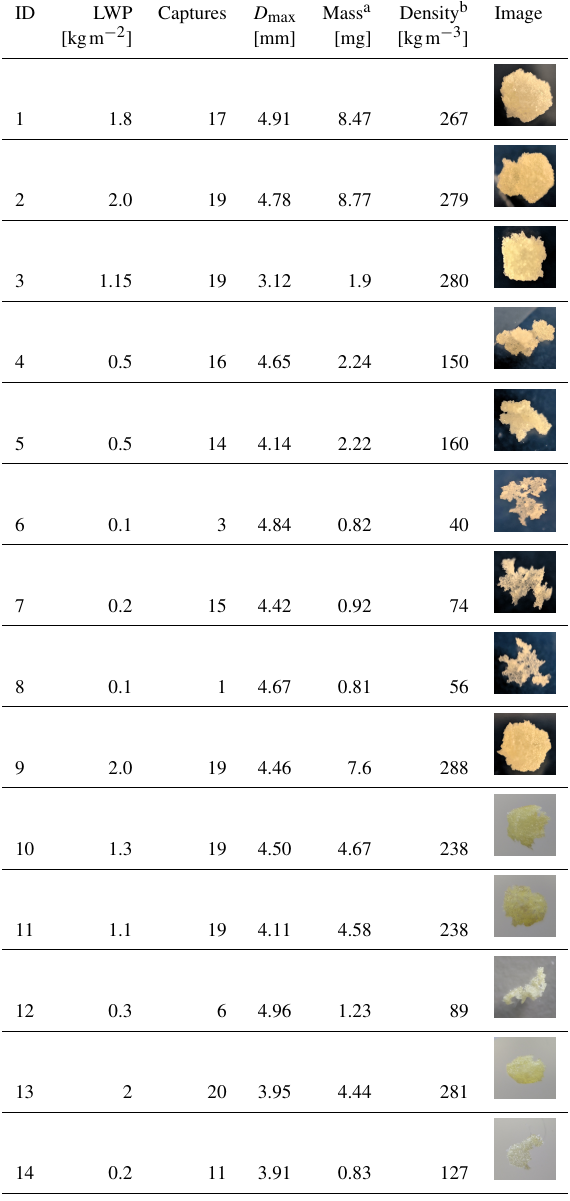
Table 1. 3D-printed snowflakes used for the evaluation of the 3D reconstruction.